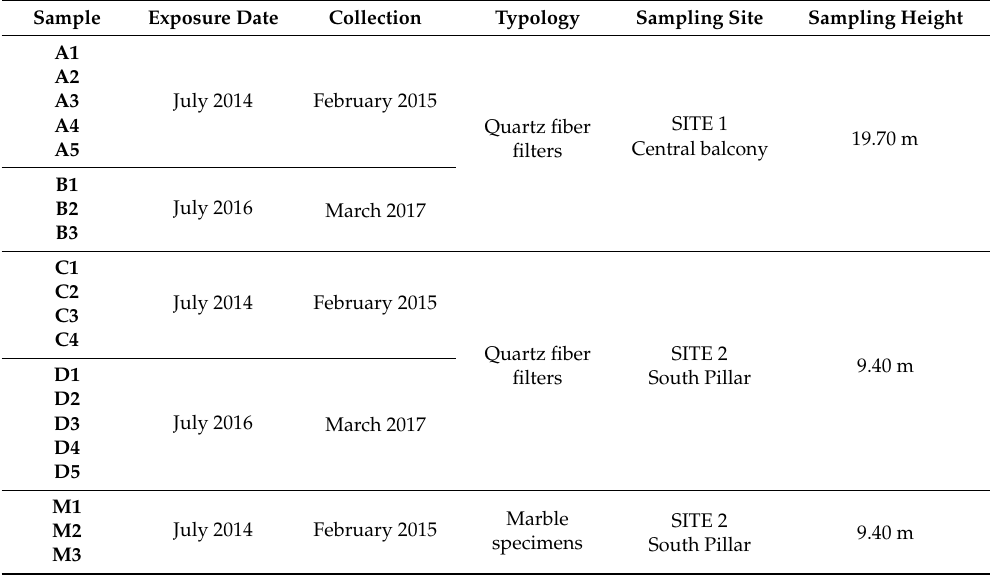
Figure 1. Scheme of the façade of the Milano cathedral (courtesy of Veneranda Fabbrica del Duomo di Milano) indicating the location of the exposure sites. Table 1. List of quartz fiber filters and marble specimens exposed on the Duomo façade in two sites at different height for two sampling periods.